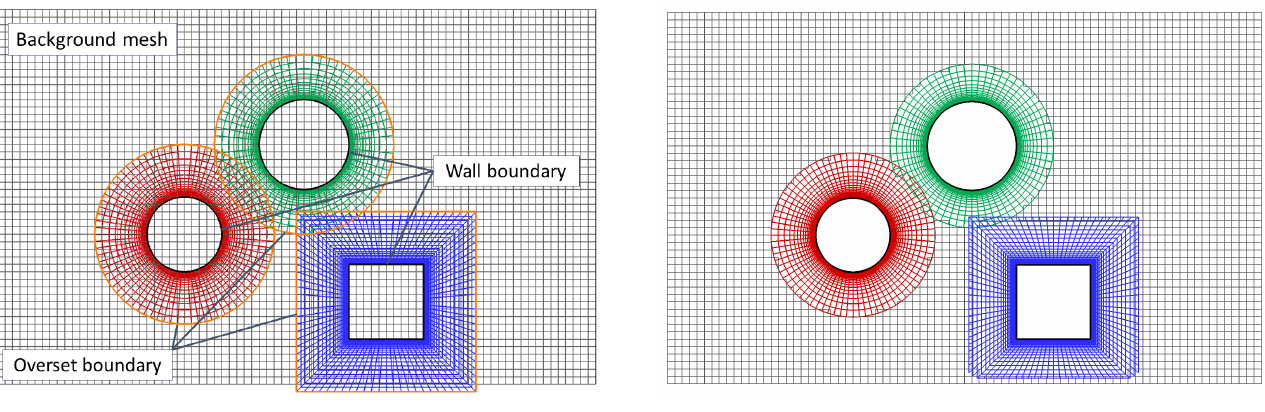
Figure 4. Exemplary visualization of the overset mesh generation using a background mesh with three component meshes.